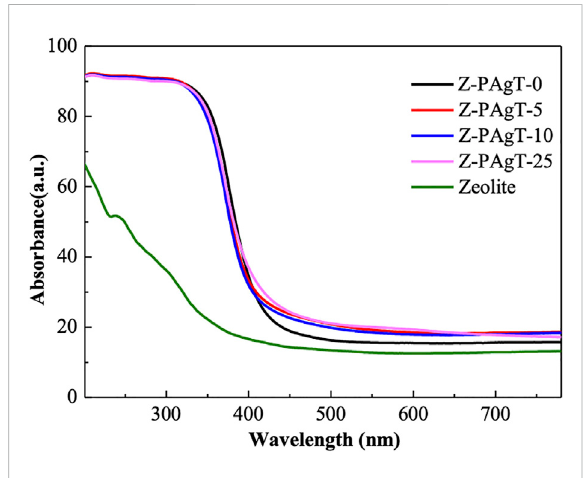
FIGURE 6 UV-vis spectra of the prepared Z-PAgT composite materials with different wt% zeolite addition and pure